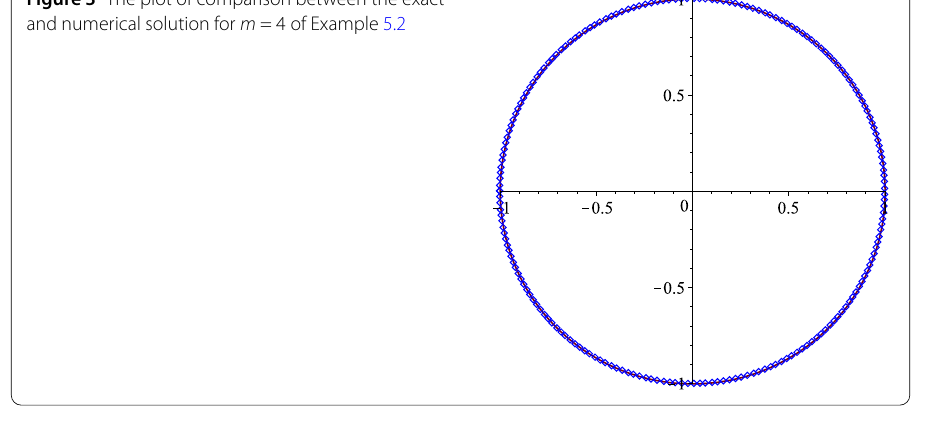
Figure 4 Plot of the absolute errors for m = 4 of Example